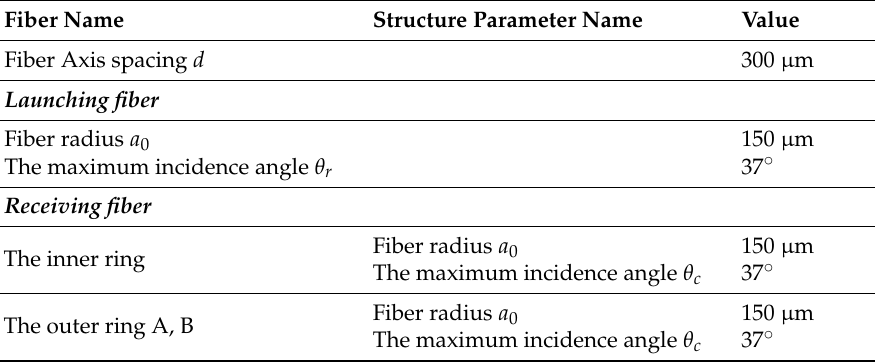
Table 1. The design parameters of the fiber probe.